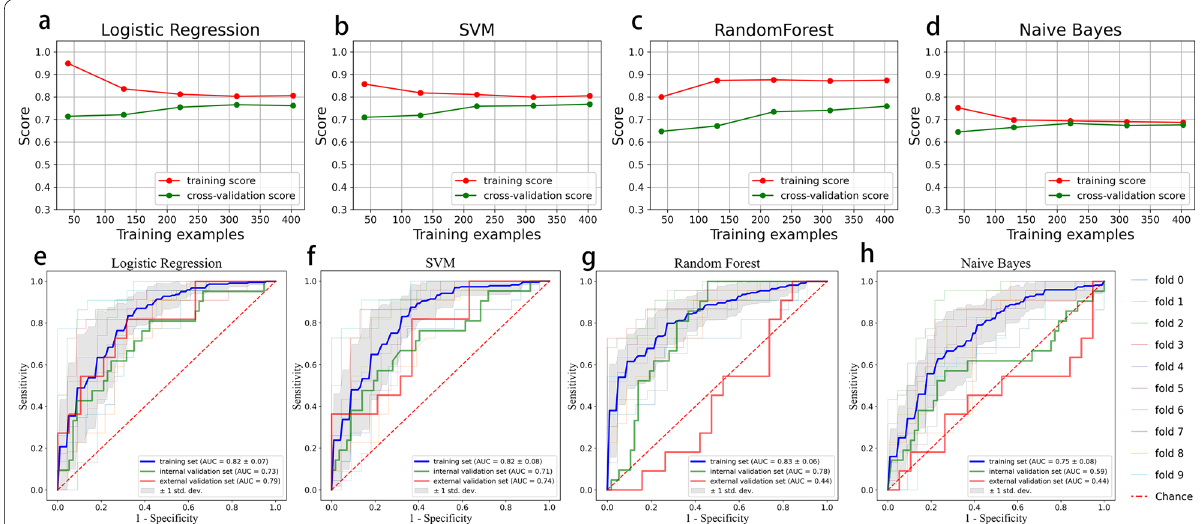
Fig. 3 a – d The learning curves for four different radiomics models. The red and green curves represent the trend of the score with the increase in sample size in training and cross-validation data, respectively. The training and cross-validation scores of the logistic regression (LR) and SVM models were higher than those of the Naive Bayes (NB) model. The gap between the training and cross-validation scores of the LR or SVM models was smaller than that of the Random Forest (RF) model. e – h The receiver operating characteristic curves for four different radiomics models. Each light-colored curve represents each of the tenfold cross-validations (fold 0 to 9), and the dark blue curve represents their mean; the red and green curves represent internal and external validation sets, respectively. The LR model and SVM model had similar AUCs in the training set, but the LR model outperformed the SVM model in both the internal validation set and the external validation set. The RF model had the highest AUC in the training set but had low AUC in the external validation. The NB model had the lowest AUCs in all sets